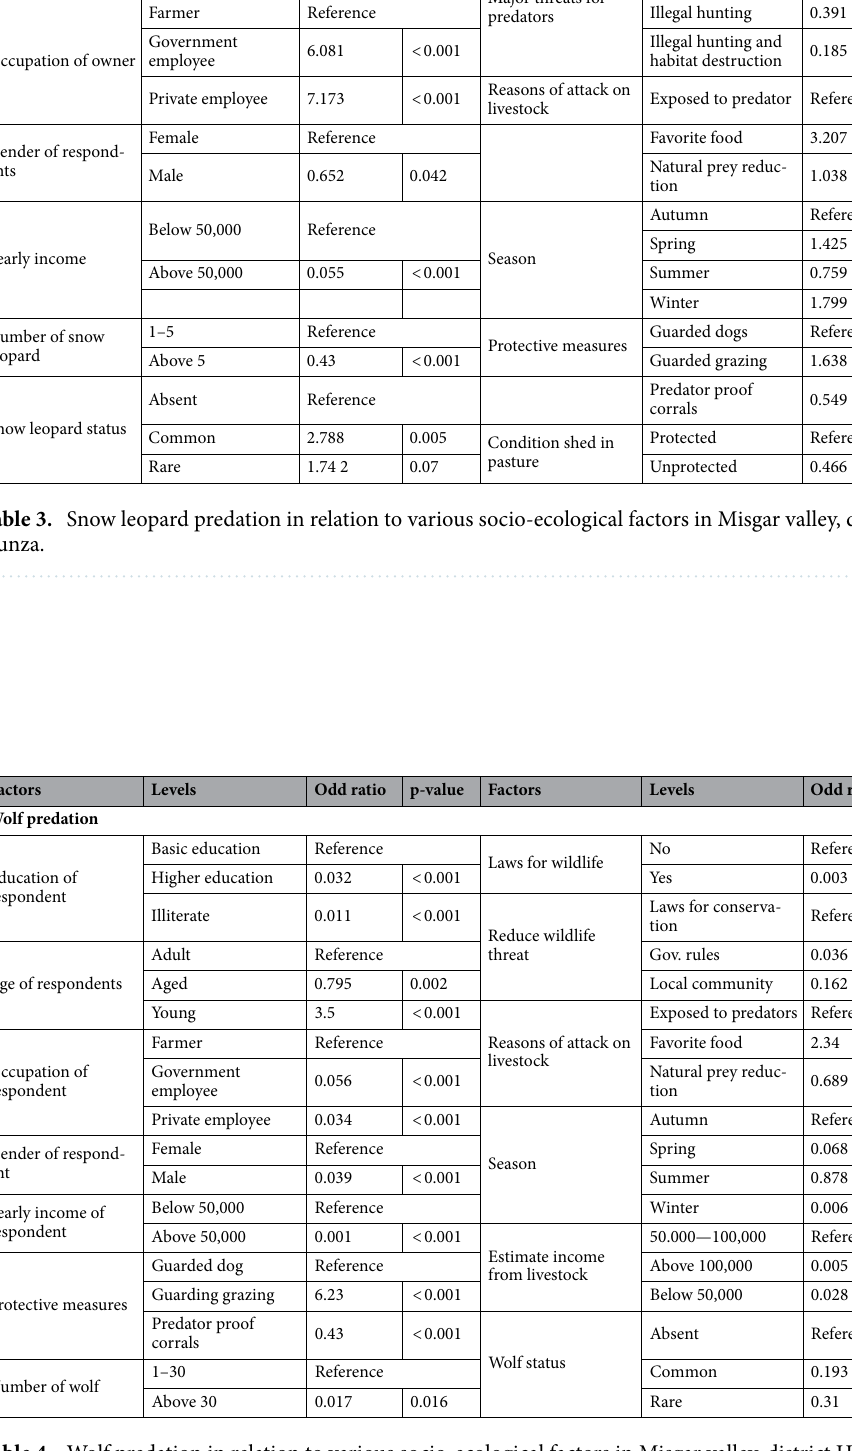
Table 4. Wolf predation in relation to various socio-ecological factors in Misgar valley, district